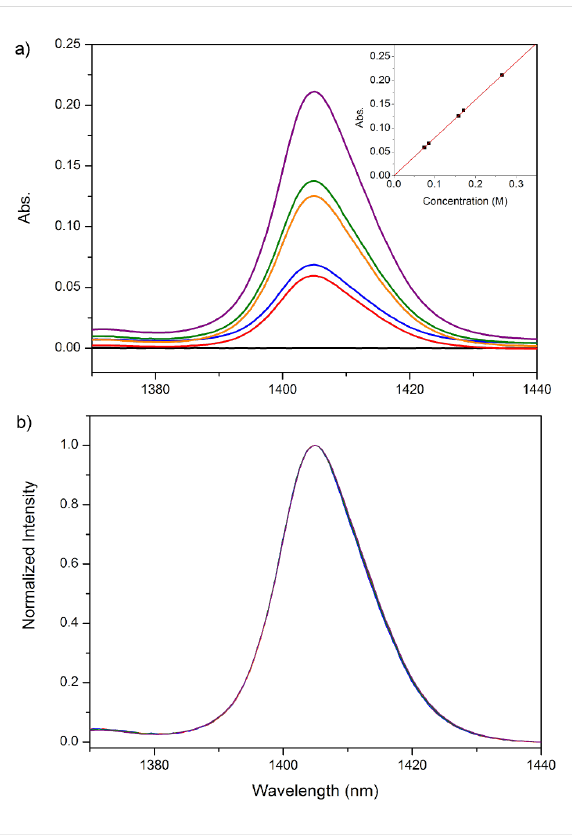
Figure 3: a) The absorption bands at 1405 nm with different amounts of water (from bottom to top: 0.000, 0.075, 0.086, 0.159, 0.171, and 0.266 M) added to dry [BMIM] + [PF 6 ] − . The inset plots the linear fitting of band intensity vs. water concentration. b) Intensity normalization of spectra in a).